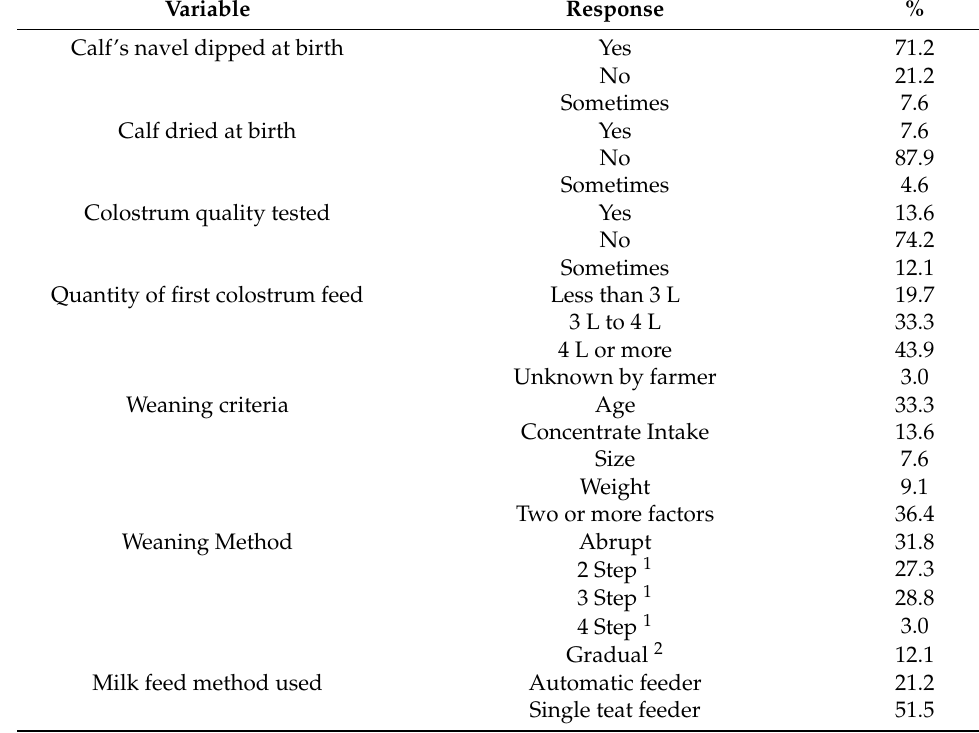
Table 3. Physical management of pre-weaned